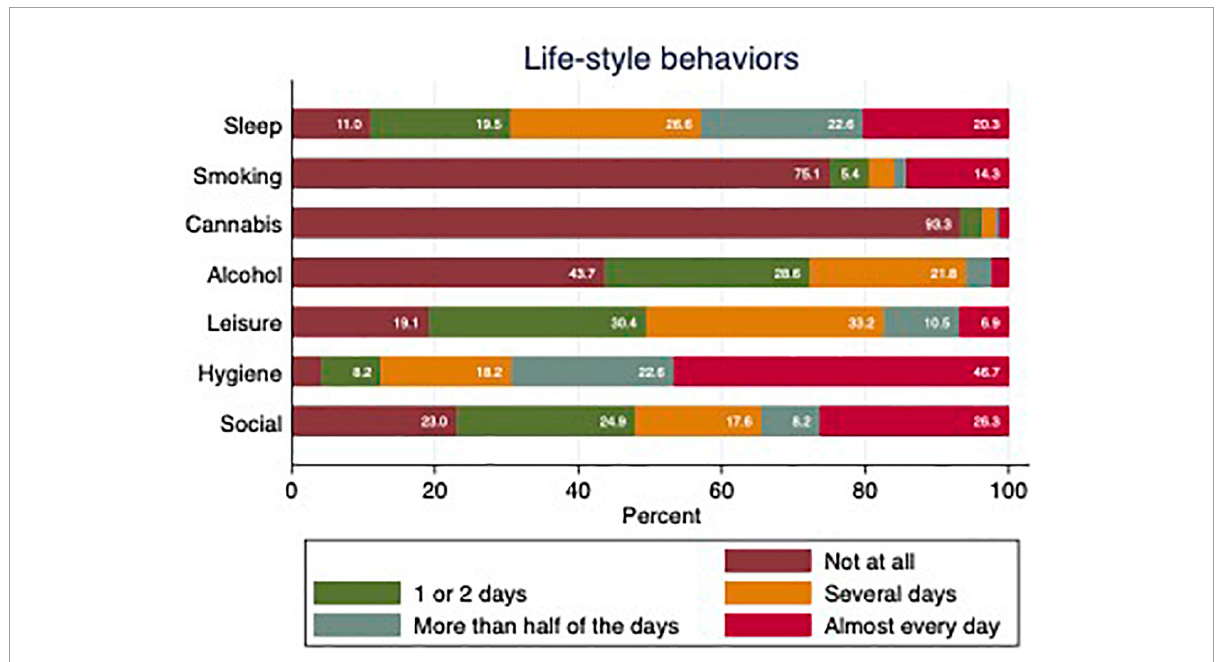
FIGURE1 Life-style behaviors during the past 2 weeks during COVID-19. Sleep refers to “Got enough sleep.” Smoking refers to “Smoked cigarettes or vaped”. Cannabis refers to “Smoked cannabis.” Alcohol refers to “Drunk alcohol.” Leisure refers to “Taken part in leisure activities you enjoy.” Hygiene refers to “Maintained normal levels of hygiene.” Social refers to “Socialized with people inside your